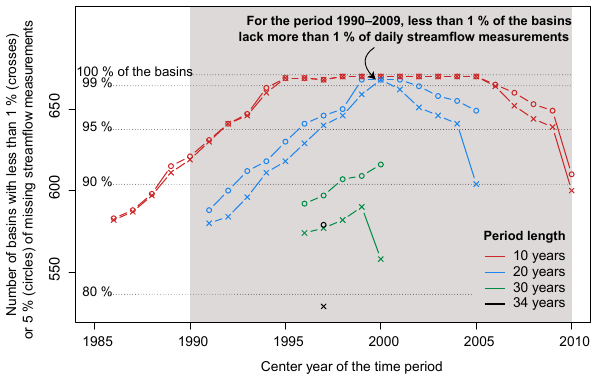
Figure 2. Availability of streamflow measurements for periods of different lengths (colors) centered on different years ( x axis). The symbols (crosses and circles) indicate the number of catchments with at most 1 or 5% of daily streamflow measurements missing, respectively. The shape of the curves indicates that the proportion of missing data decreases from 1980 to 1990, stays low, and then increases after 2010. Note that years are hydrological years (starting on 1